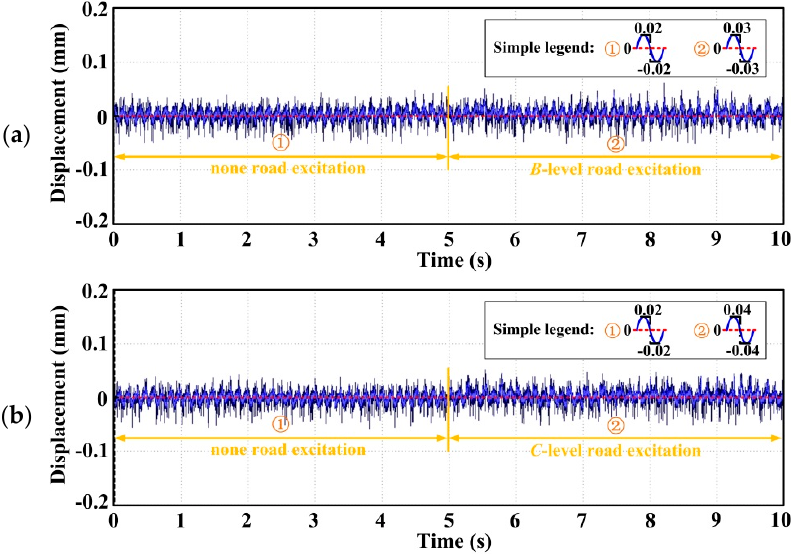
Figure 13. Changes in axial displacement when different levels of road surface are applied. ( a ) B-level road surface. ( b ) C-level road surface.